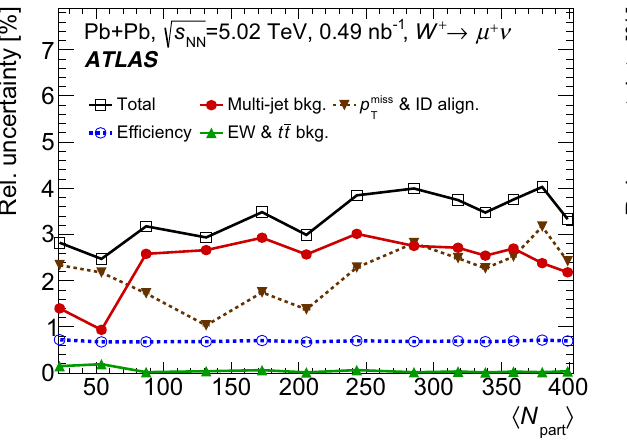
Figure8showsacomparisonbetweenleptonchargeasym- metries obtained for the electron and muon decay channels as a function of the charged-lepton absolute pseudorapidity. Good agreement is found between the two decay modes, which supports the combination of the two datasets. The resulting combined data points are also shown on the same figure. Figure 9 shows a comparison of the normalised produc- tion yields for W + and W − bosons obtained for the electron and muon decay channels, as well as their combination, as a function of the event centrality (represented by (cid:4) N part (cid:5)